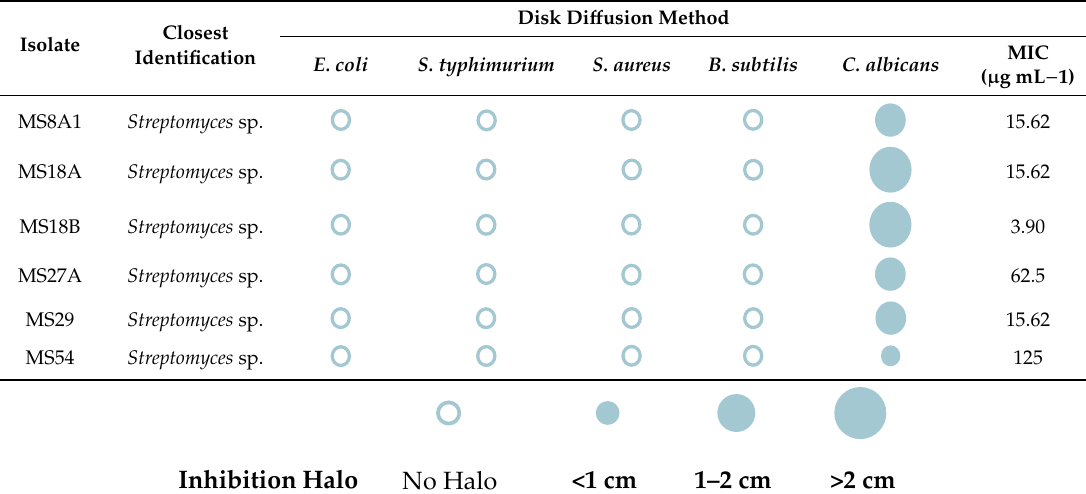
Table 1. Actinobacteria isolates obtained in this study with antimicrobial activity. MIC: Minimal inhibitory concentration.